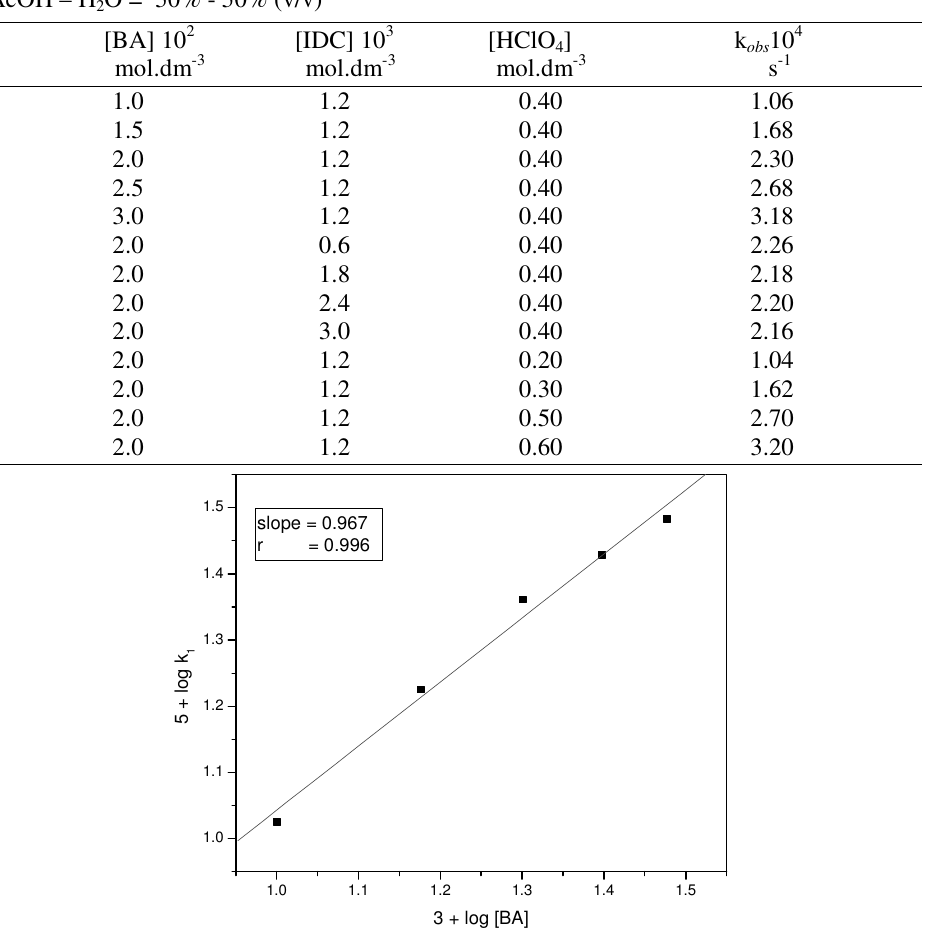
Figure 1 . Variation of rate with benzaldehyde